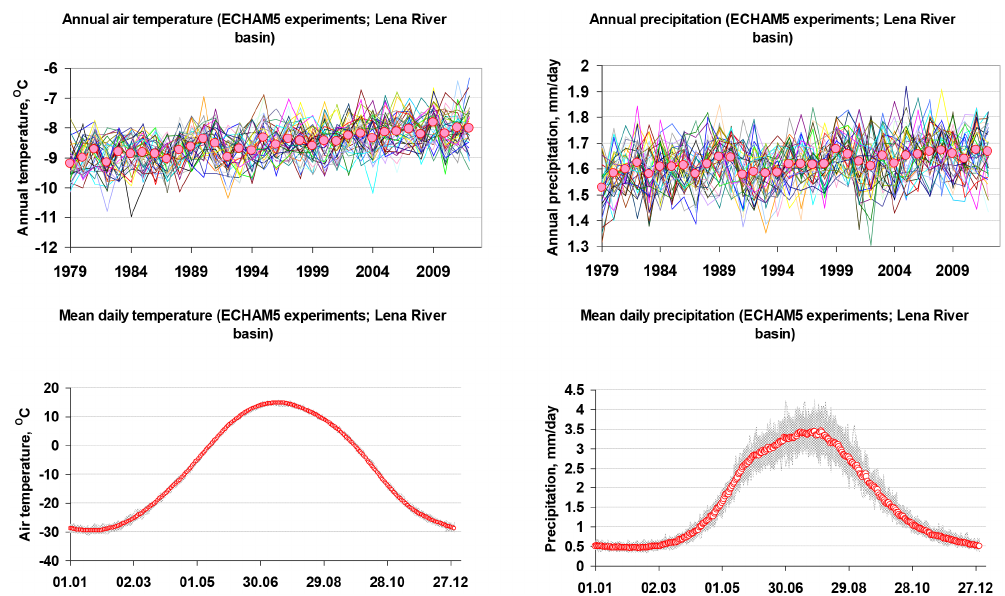
Figure 2. ECHAM5-simulated ensembles of mean annual surface air temperature (SAT) (top left panel) and precipitation (top right panel), as well as mean daily SAT (bottom left panel) and precipitation (bottom right panel) averaged over the Lena River basin. Dots in the top figures and the bold line in the bottom figures denote corresponding ensemble mean